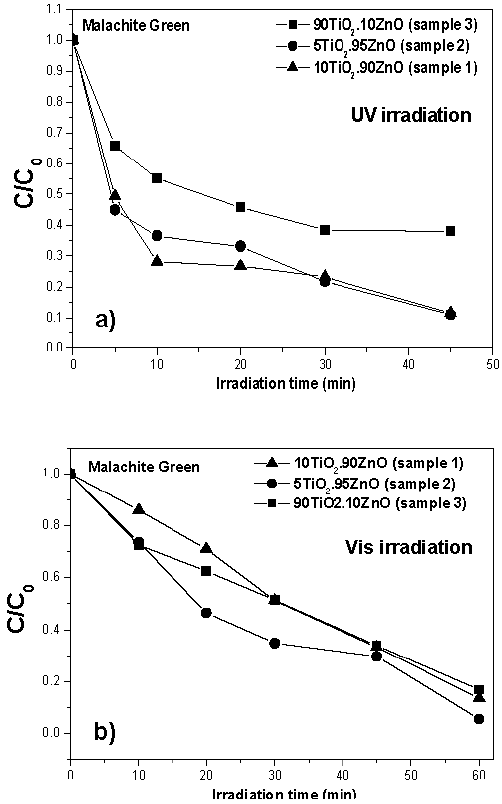
Figure 6. Photocatalytic degradation of Reactive Black 5 (RB5) by the investigated samples under UV (a) and Vis (b) irradiation